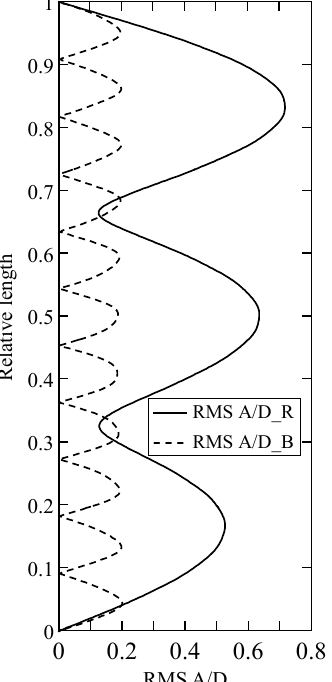
Table 11. Comparison of the prediction and measurements for the 2/2 configuration at U = 1.0 m/s.